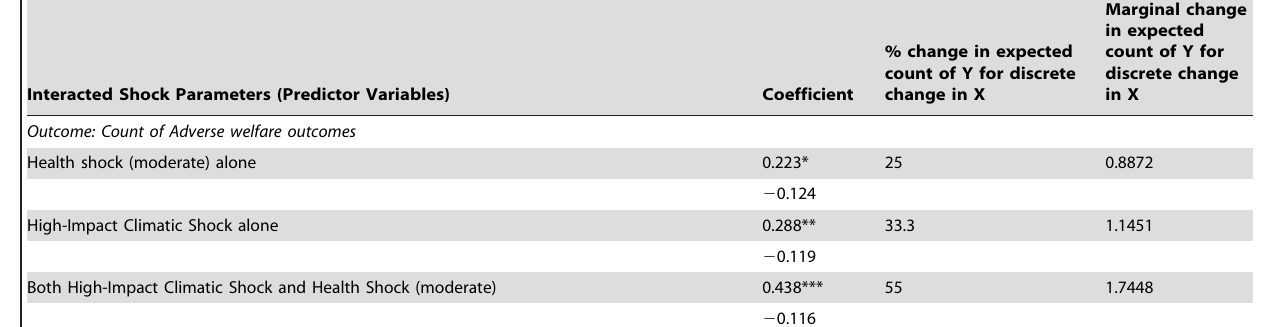
Interacted Shock Parameters (Predictor